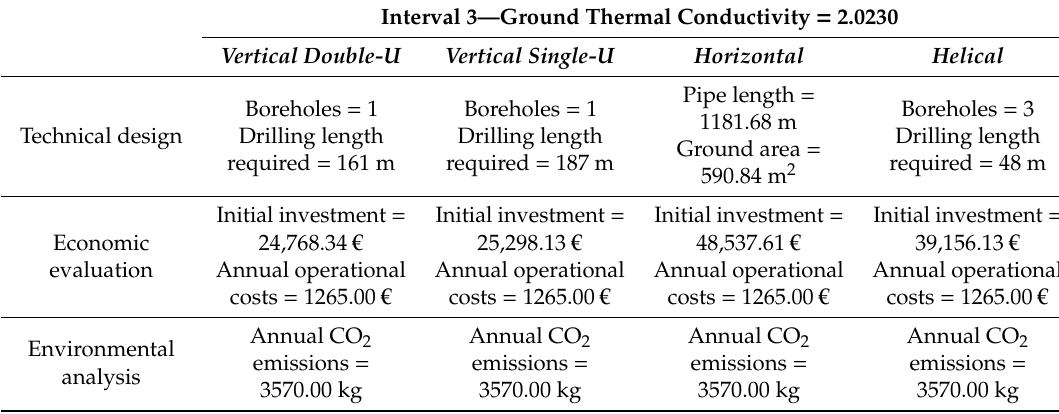
Table 7. Design provided by GES-CAL software for the geothermal system under study, interval 3.